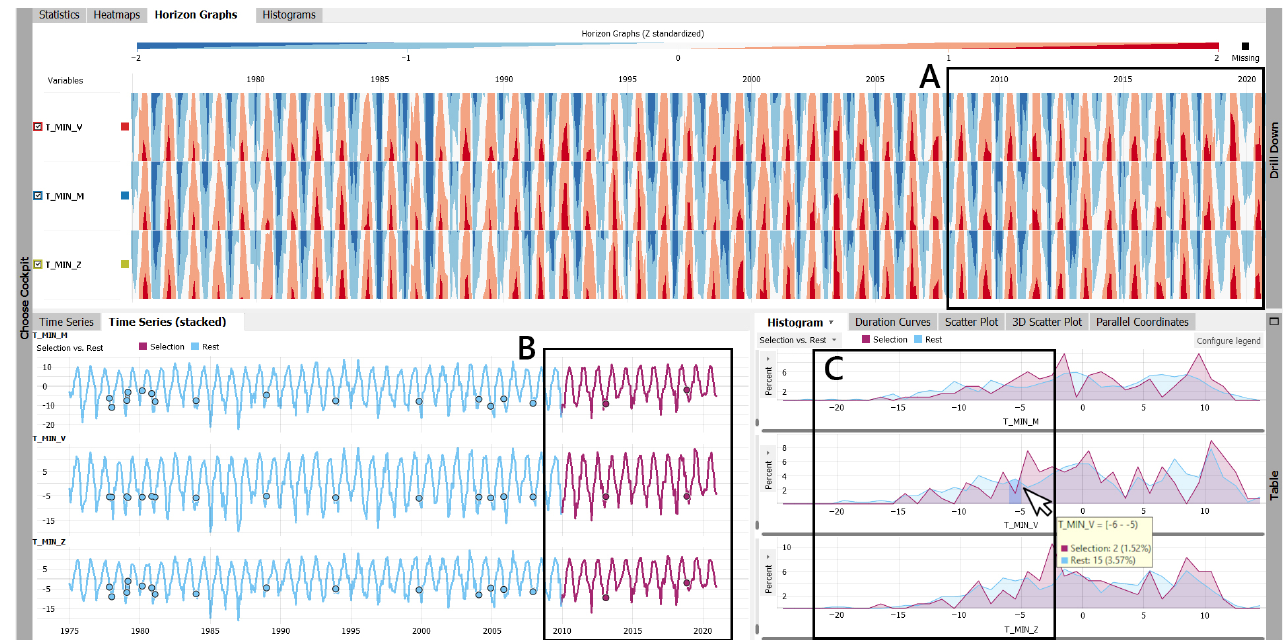
Figure 4. Warming progression denoted for air temperature minima with higher frequency of temperatures not exceeding − 5 °C in the past 10 years in comparison to the remaining 35 years: ( A ) the observed higher representation of temperature peaks marked in red; ( B ) the highlighted individual data points denoting instances of air temperature below − 5 °C in 2010–2020 period; ( C ) shifting of the frequency area towards generally higher values for temperature minima.